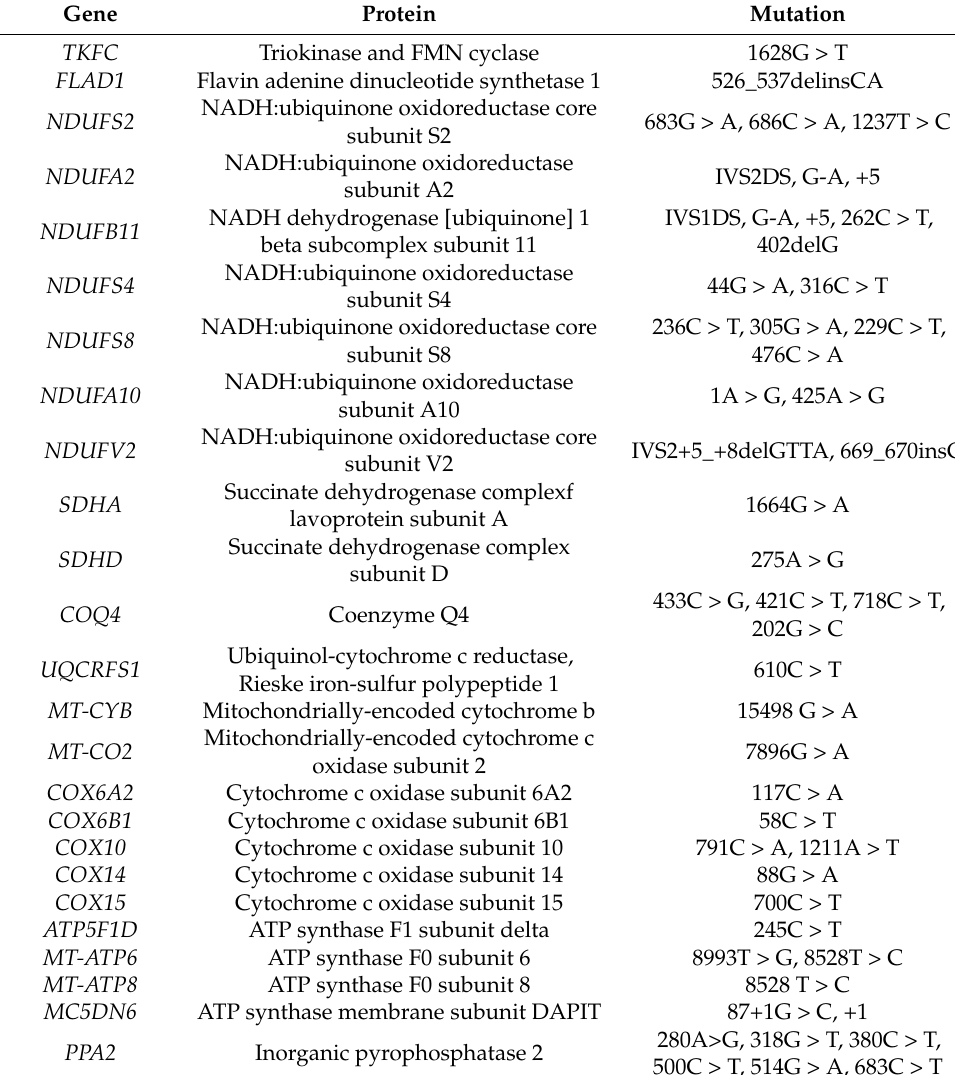
Table 1. nDNA and mtDNA mutations resulting in mitochondrial